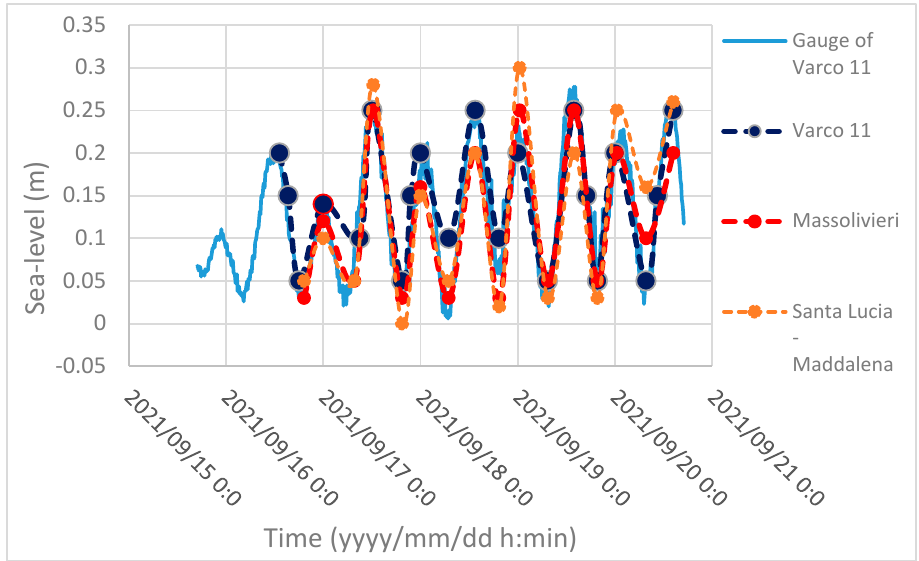
Figure 9. Tide values obtained from CNN outputs for Varco 11, Massolivieri, and Santa Lucia, compared with data from tide gauge sensor installed in Varco 11.